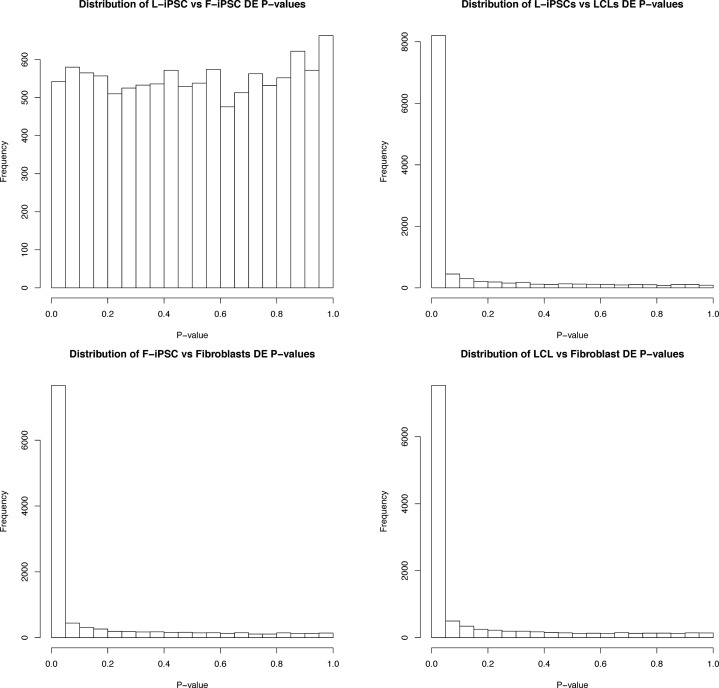
Histograms of P-values from DE tests.Histograms of P-Values from differential expression analysis.